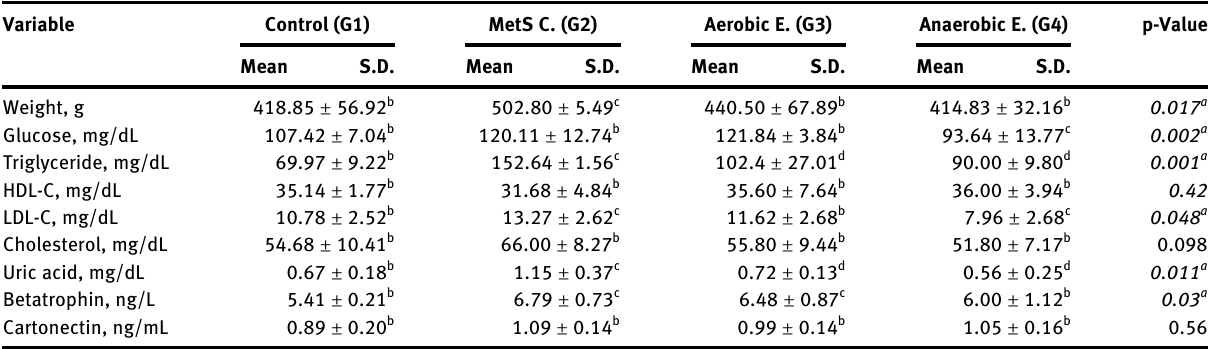
Table  : Descriptive data of the groups.